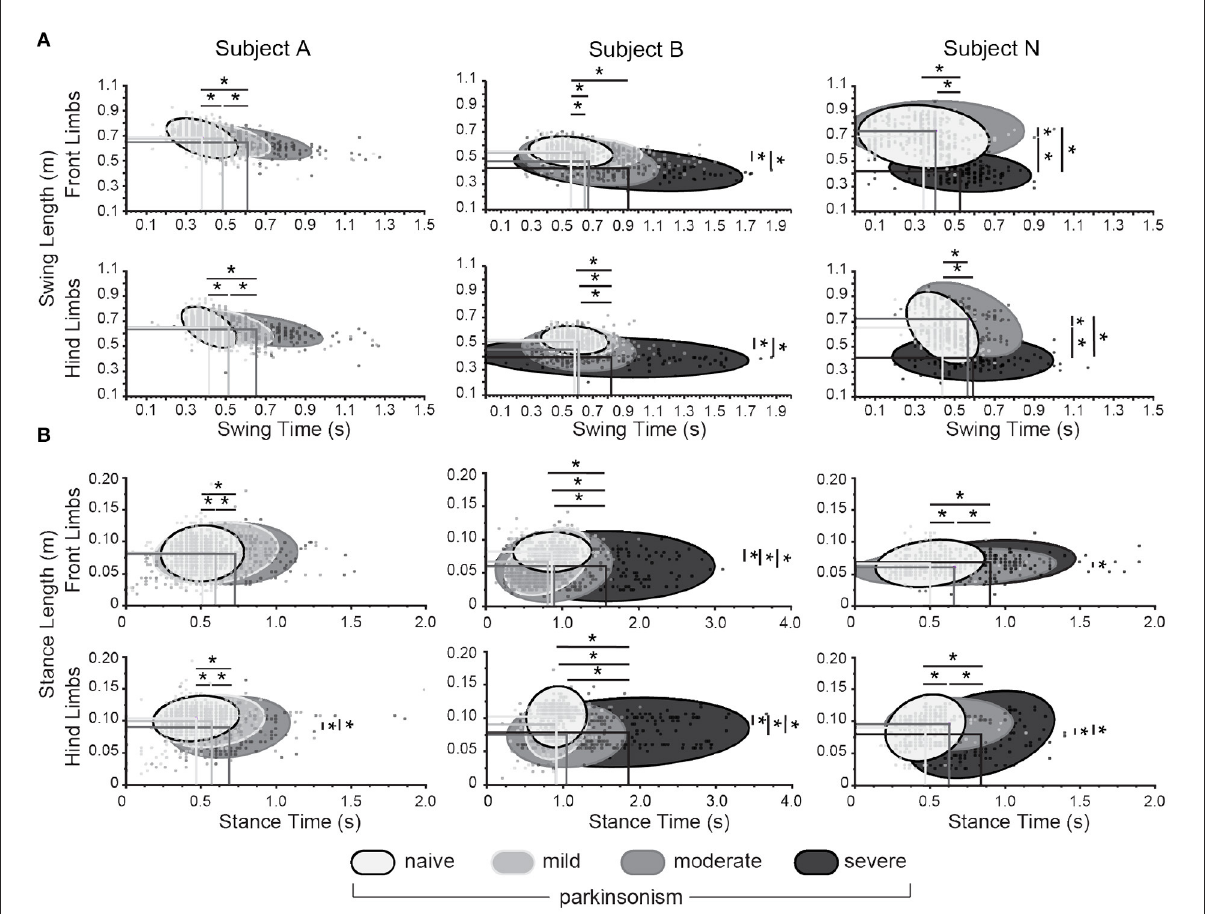
FIGURE4 Changes in swing and stance phases between naïve and parkinsonian states. (A) Comparison of swing length (y axis) and swing time (x axis) of the front (top row) and hind (bottom row) limbs. Shaded ellipses represent 95% confidence intervals about the respective data set. Lines intersect at the mean swing time and swing length for the given state. (B) A similar comparison between stance time and stance length of the front (top row) and hind (bottom row) limbs. *denotes a significant difference (p < 0.05) of the variables between